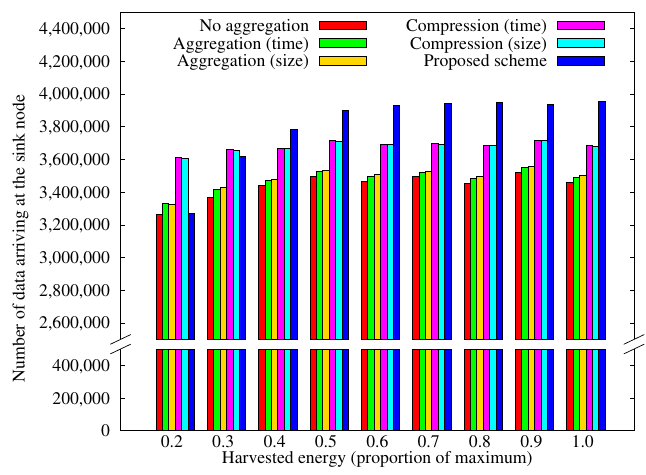
Figure 10. Comparison of the amount of data obtained according to the solar energy.